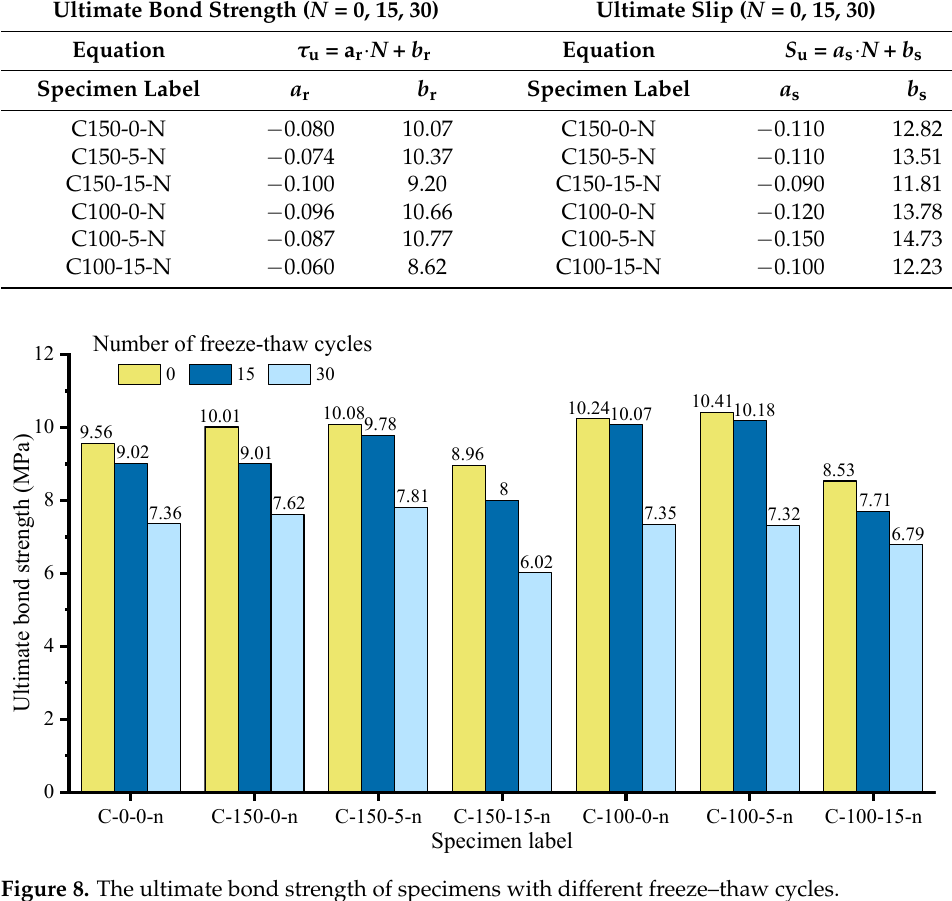
Table 6. The ultimate bond strength and ultimate slip as a function of freeze–thaw cycle number N . Ultimate Bond Strength ( N = 0, 15, 30)